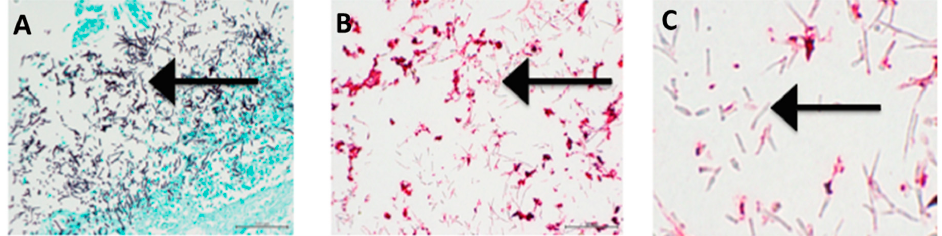
In the upper left corner was human tissue not stained with antibody (~300 × ).